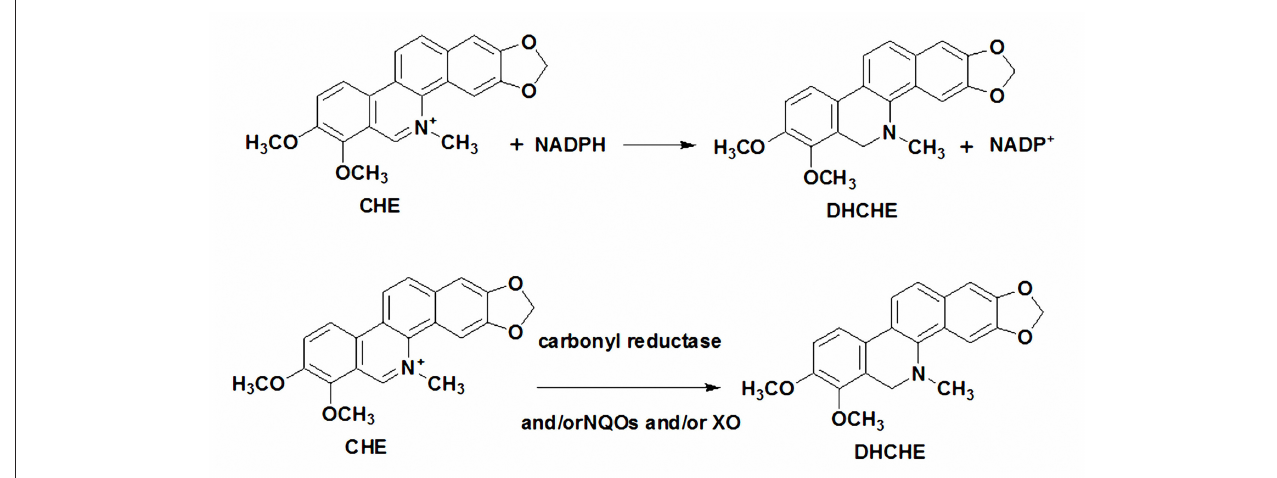
FIGURE 6 | The mechanism of chelerythrine reduction in the rat liver